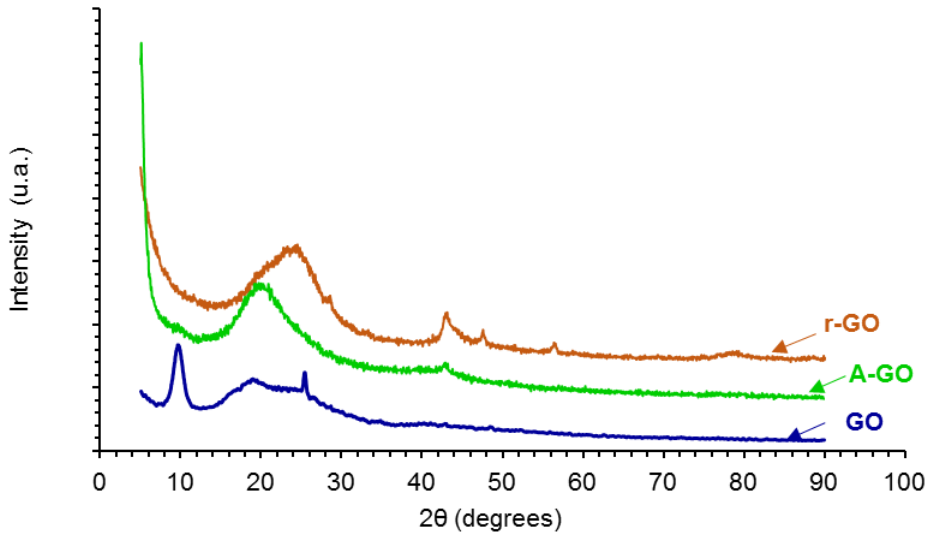
Figure 5. X-ray diffractograms of the graphene oxide derivatives.